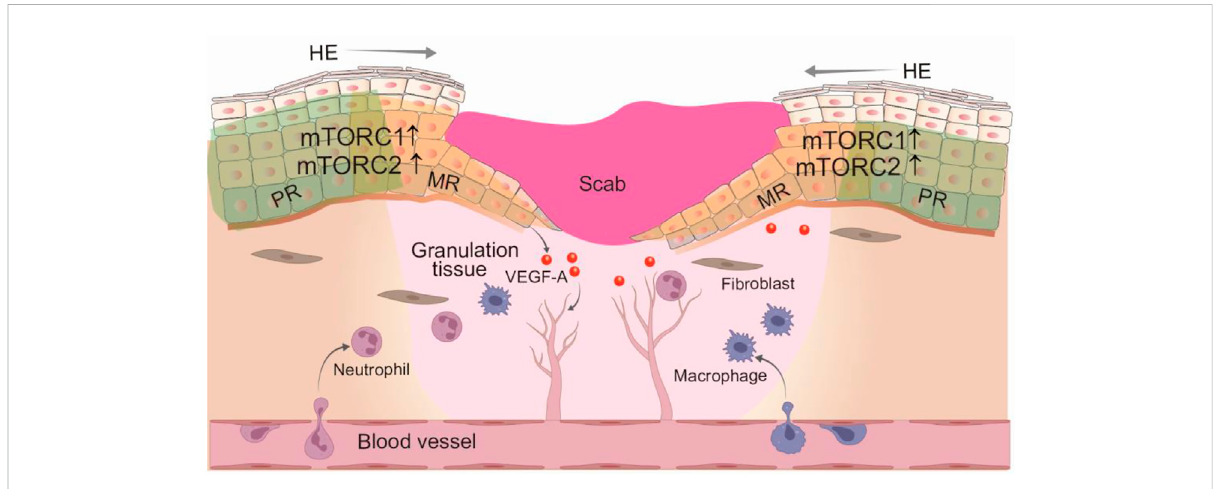
FIGURE 4 RegulationofwoundepithelizationandangiogenesisbymTORsignaling.Skinwoundhealingisawell-organizedprocessthatinvolvesdynamic and overlapping phases: in fl ammation, cell proliferation and migration, and tissue remodeling. In response to various growth factors and cytokines, multiple sourced keratinocytes at the wound edge are activated to promote epithelization through enhanced proliferation and migration. Both mTORC1 and mTORC2 signaling activity are robustly induced in the hyperproliferative wound epithelium, promoting wound cell proliferation and migration. In addition, activated mTORC1 also regulates angiogenesis through increased VEGF-A expression. HE, hyperproliferative epithelium; PR, proliferative ring; MR, migration